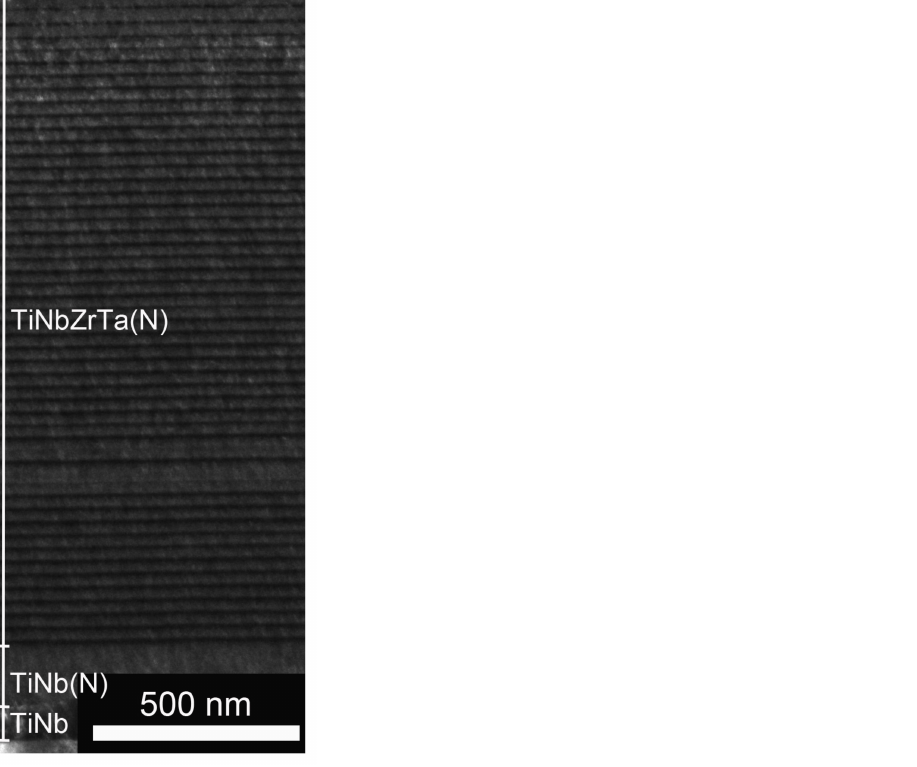
Figure 2. Low-magnification transmission electron microscope image of the TiNbZrTa(N) coating section. Table 2. Material parameters of coating and indenter [13–16].